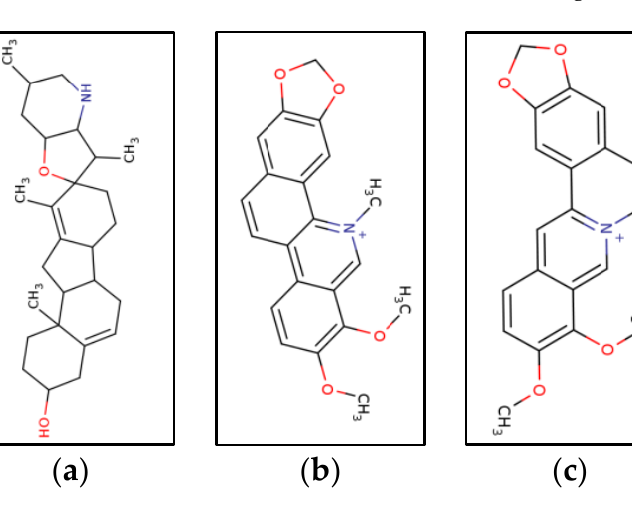
Figure 5. Chemical structures of the selected ligands. ( a ) Cyclopamine. ( b ) Chelerythrine. ( c ) Berberine. ( d ) Tanshinone 2A. ( e ) Catharanthine. Structures were prepared in ChemDB Cheminformatics portal (http://cdb.ics.uci.edu/cgibin/Smi2DepictWeb.py (accessed on 31 July 2022). Table 2. Top ligands with high druggability and BBB crossing.